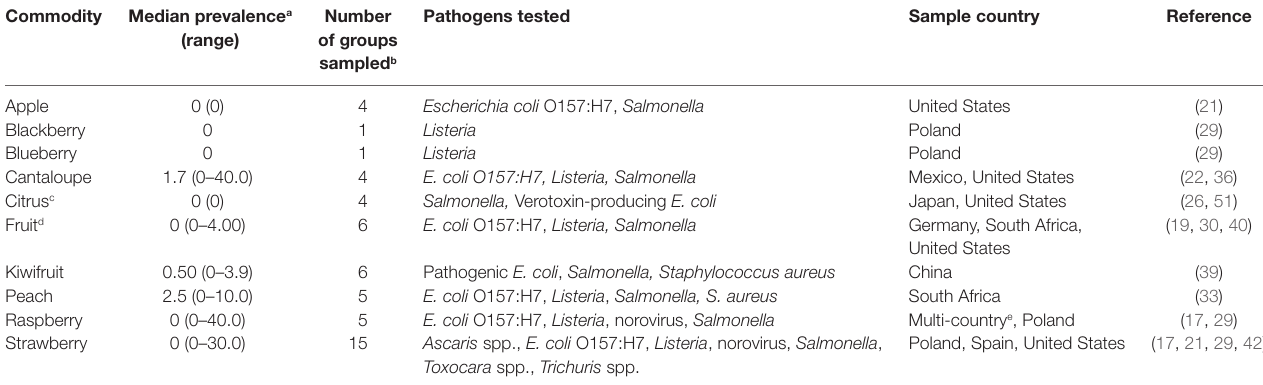
tabLe 5 | Pathogen prevalence by fruit